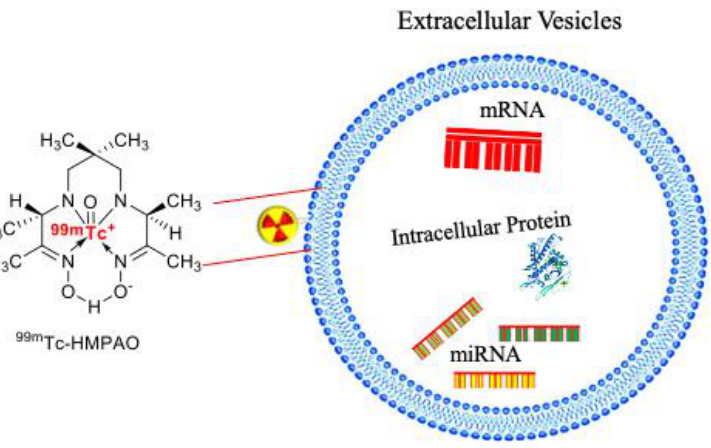
Figure 3. A schematic overview of radioactive technetium ( 99m Tc) on the EVs membrane surface.